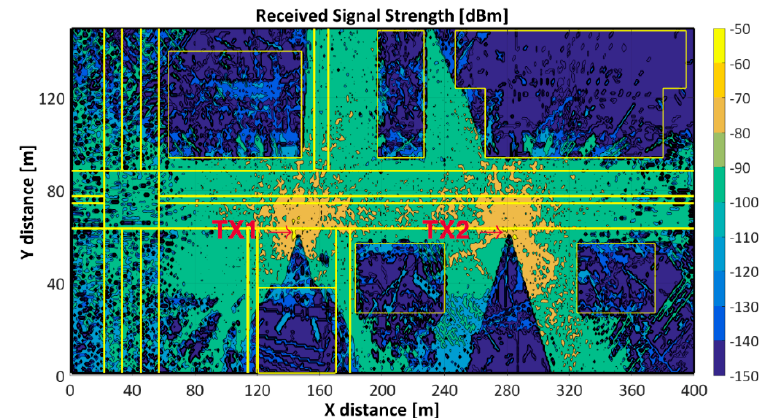
Figure 2. TX1 and TX2 jointly Received Signal Strength [dBm] at Z-plane of 1.5 m.